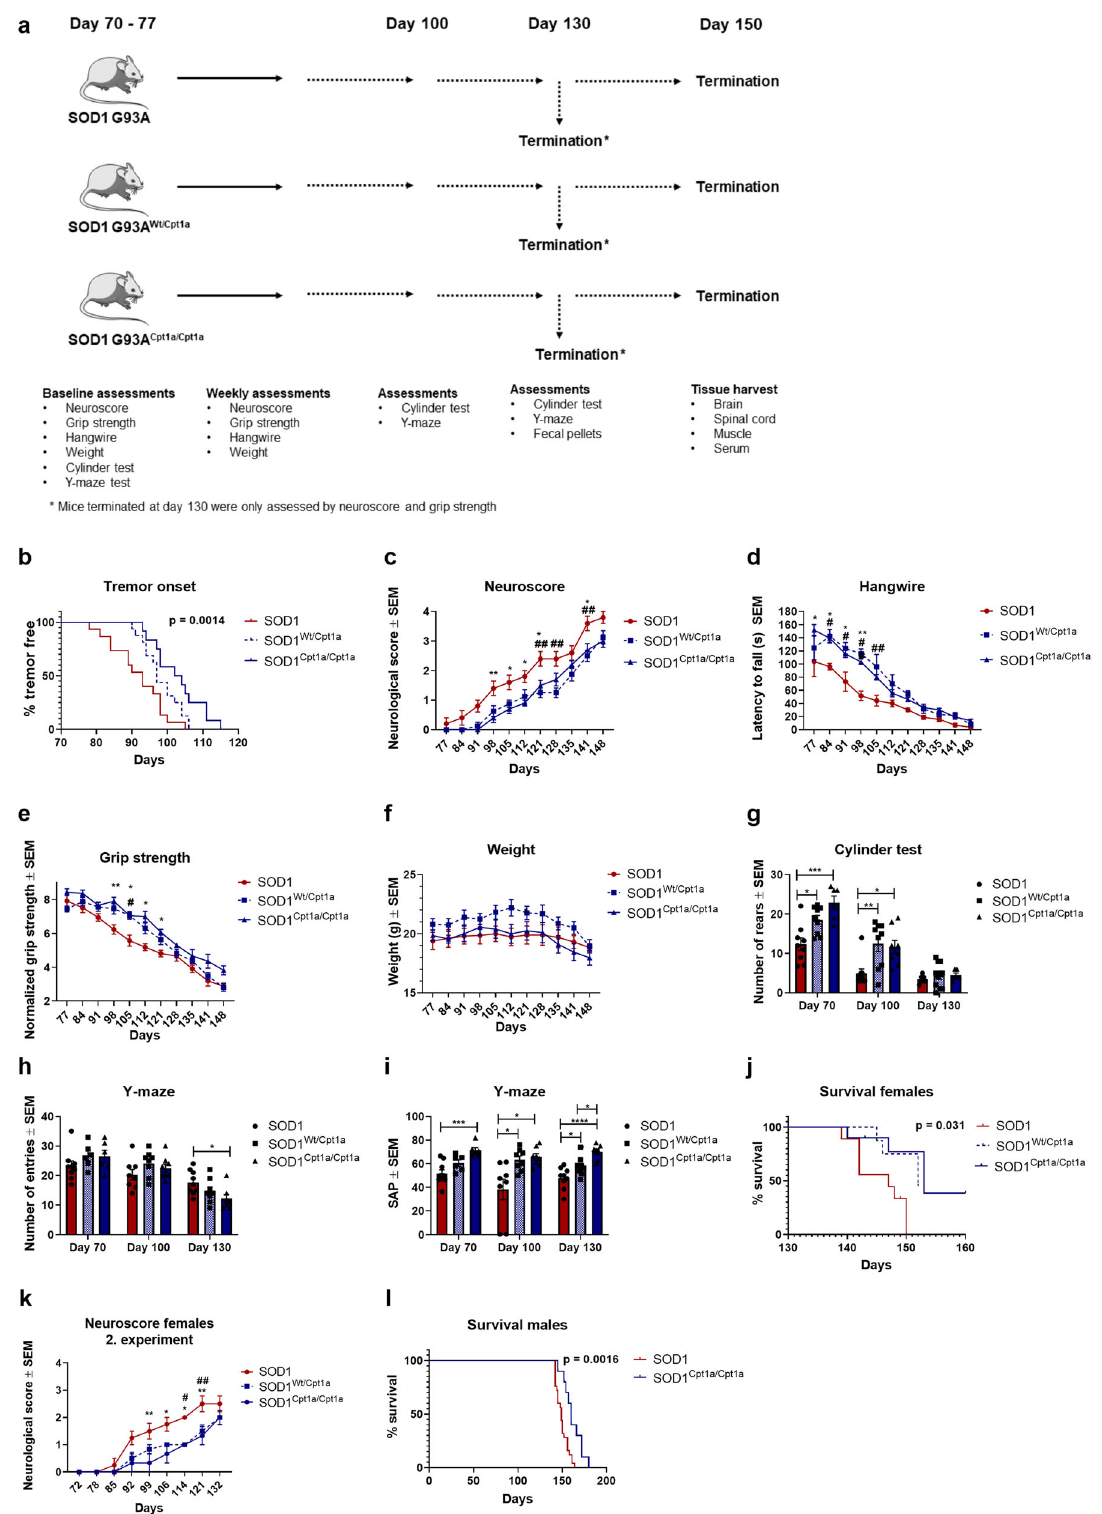
lower degree of muscle atrophy compared to SOD1 mice (Fig. 6n), but the difference was not signi fi cant. In addition, SOD1 Wt/Cpt1a and SOD1 Cpt1a/Cpt1a mice had lower levels of MuRF1 (Fig. 6o) in accordance with the higher normalized weight of muscle tissue (Fig. 6n). Further, SOD1 Wt/Cpt1a mice had a tendency towards a signi fi cantly lower level of the atrophy marker atrogin-1 16 compared to SOD1 mice (Fig. 6o). Next, we evaluated the